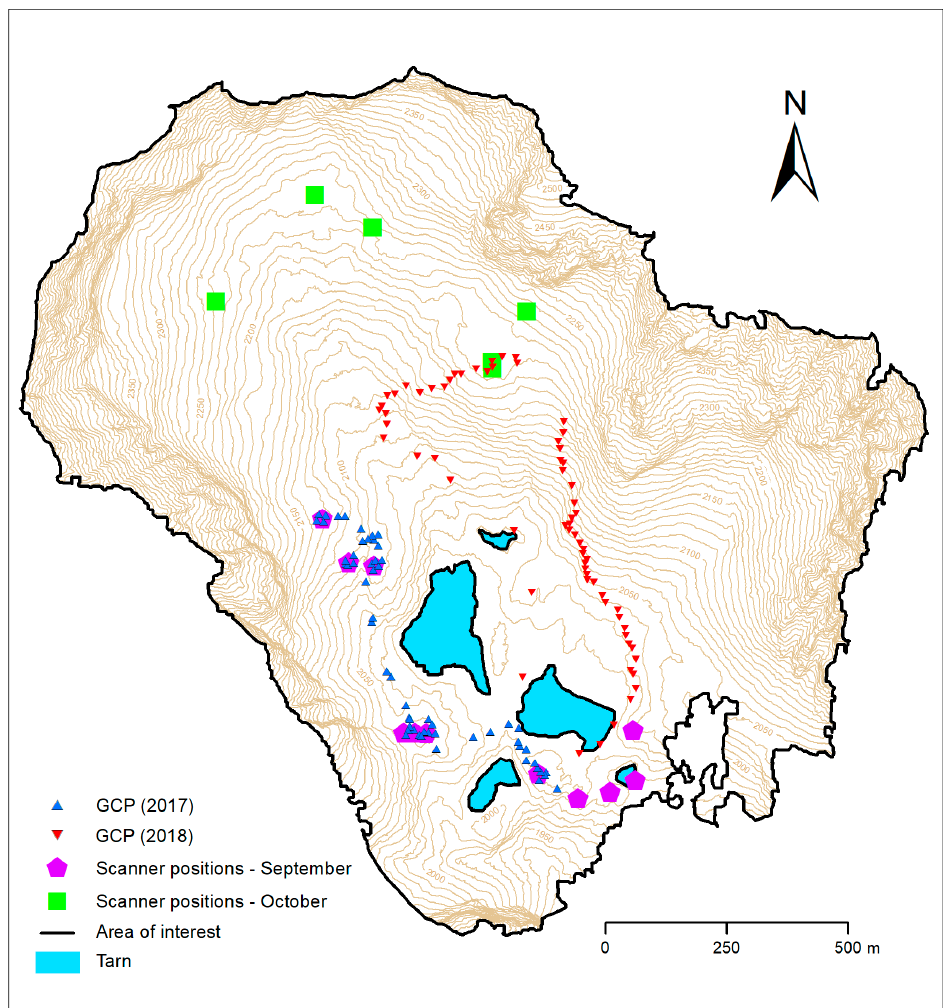
Figure 4. Location of the TLS stations and ground control points (GCPs) acquired with real-time kinematic (RTK) GNSS. Contours are derived from the final DEM with vertical interval of 10 m.